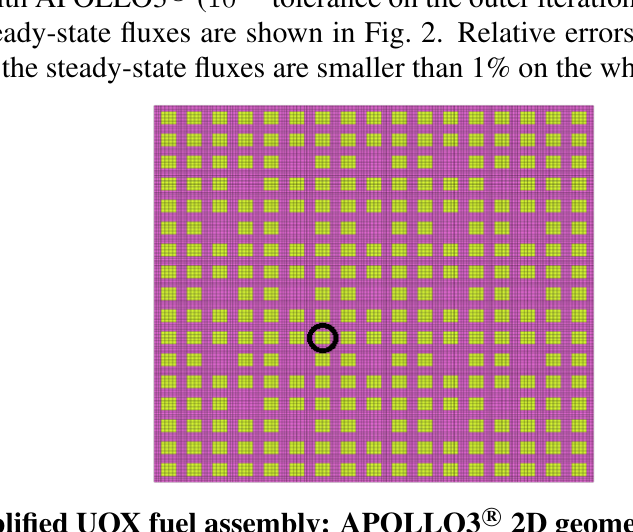
Figure 1: Simplified UOX fuel assembly: APOLLO3 R (cid:13) 2D geometry with spatial meshes. The perturbed fuel pin is marked in black.